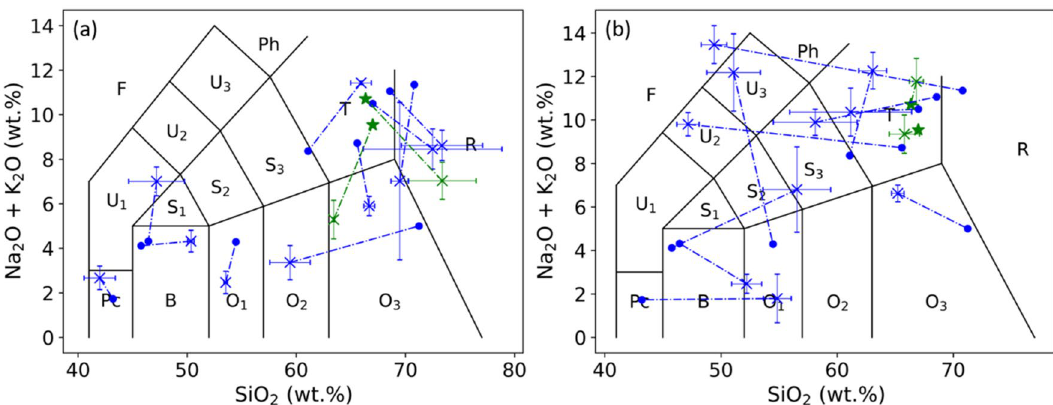
Figure 7. TAS classifications of the validation polished rock samples ( a ) and raw rock samples ( b ) using the machine learning models. The reference positions determined by XRF are presented in colored solid stars and circles respectively for the isolated rocks and the rest of the validation rocks, the corresponding model-predicted mean positions are presented with crosses in the same colors with associated error bars. A dashed line links the XRF reference position and the model-predicted position of a same rock sample. The error bars are calculated over the different pretreated spectra of a given cross represents the mean position calculated with the 21 pretreated replicate spectra of a sample. The error bars represent the standard deviations ( ± SD ) of the concentrations over the replicate spectra, in particular the vertical error bars were obtained by summing the SD s for the 2 concerned compounds. A dash-dot line further links the